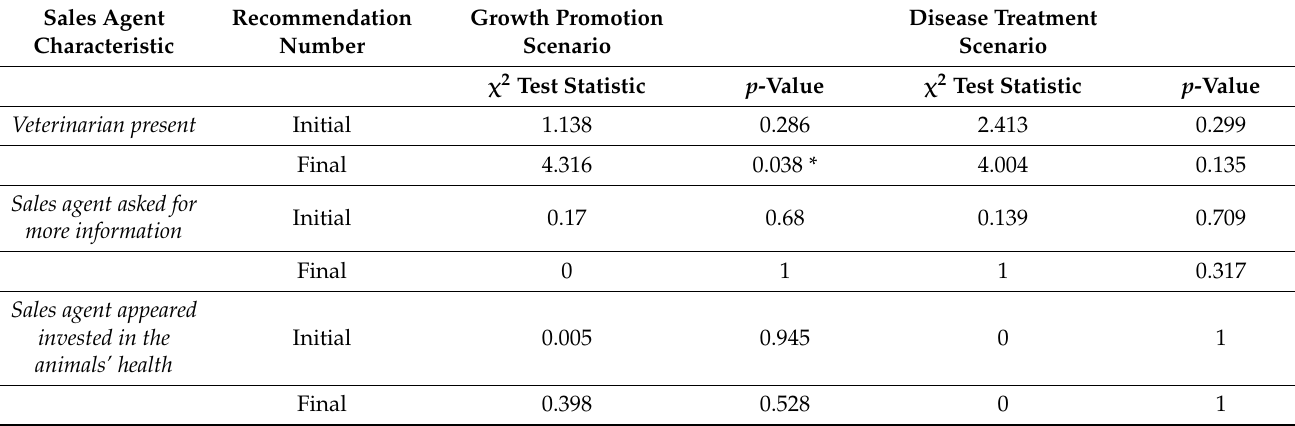
Table 5. Bivariate relationships 4 between sales agents’ characteristics and antibiotic recommendation